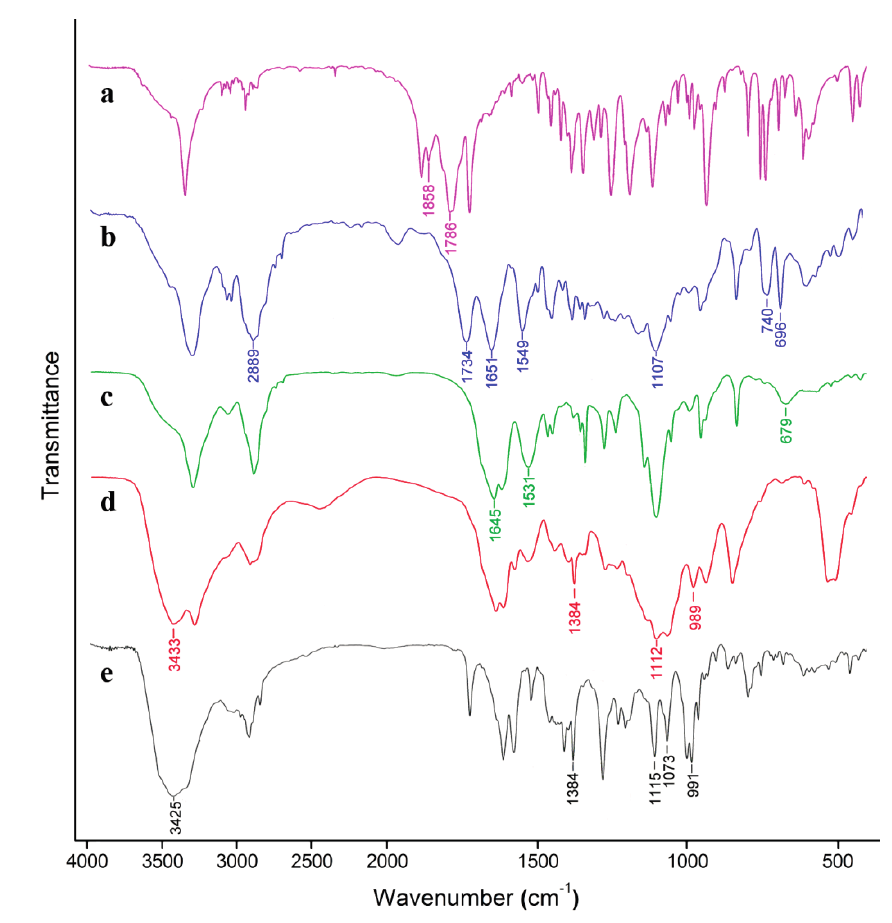
Figure 1. Fourier transform infrared spectroscopy spectra of: BLG-NCA ( a ); PEG-(PBLG) ( b ); PEG-poly(Glu-Hyd) ( c ); PEG-poly(Glu) -DOX polymers ( d ) and DOX·HCl ( e ). 2 2